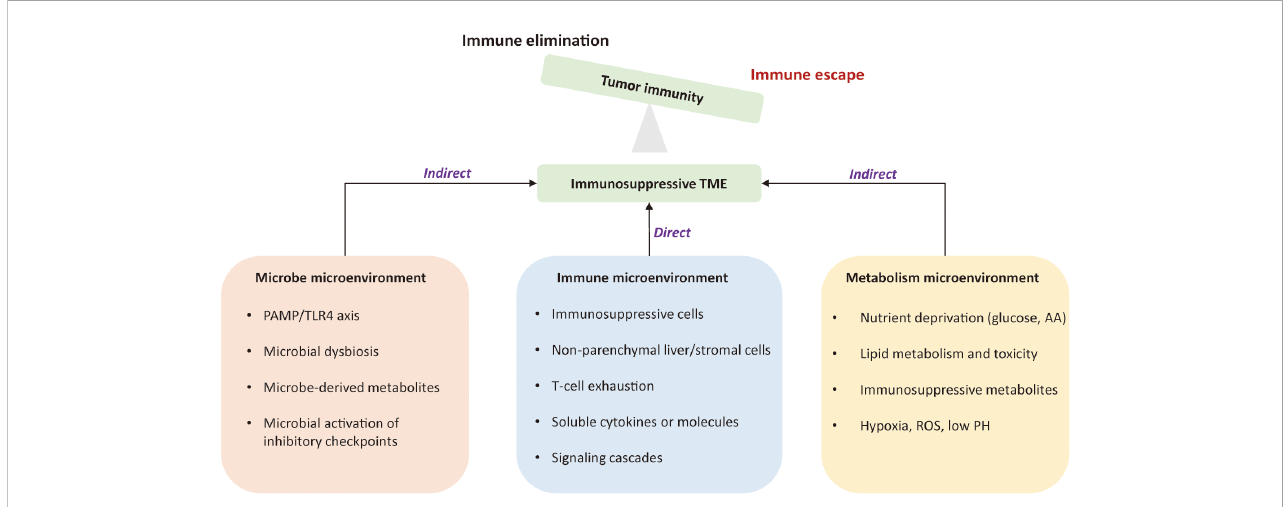
FIGURE 1 Mechanisms of immune evasion led by the tumor microenvironment in hepatocellular carcinoma. The immunosuppressive tumor microenvironment is an external driver of immune evasion in HCC. The suppressive immune microenvironment is led by intricate interactions among suppressive immune cells, stromal cells, immunoregulatory cytokines, and signaling cascades. Metabolic constraints and gut microbiota also contribute to the immunosuppression. The permissive microenvironment favors tumor cells to proliferate in un uncontrolled manner and is no longer con fi ned by the host immunity. TME, tumor microenvironment; PAMP, pathogen-associated molecular patterns; TLR4, Toll-like receptor 4; AA, amino acid; ROS, reactive oxygen